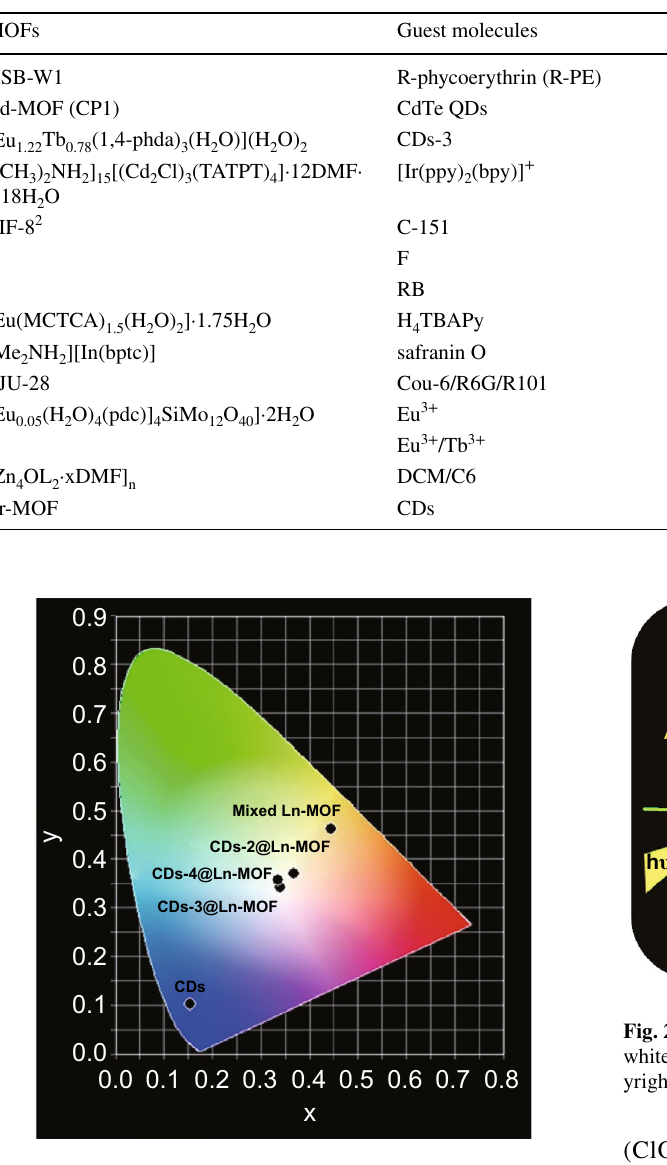
Fig. 23 CIE chromatic diagram of CDs, mixed-LnMOF, and CDs@ LnMOF hybrids. CDs-2, CDs-3, and CDs-4 refer to 2, 3, and 4 mL of CDs encapsulated into MOFs, respectively. Reprinted with permis- sion from Ref. [63]. Copyright 2019, American Chemical Society